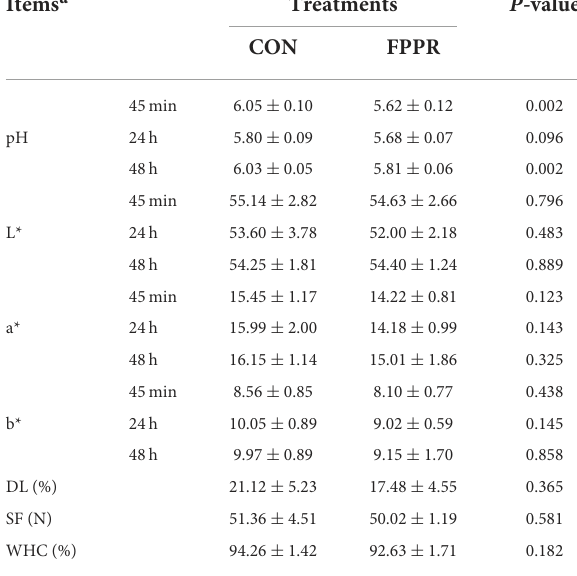
TABLE 2 Effect of the partial substitution of fermented pineapple peel residue (FPPR) for WSC on the meat quality of longissimus dorsi in Chuangzhong black goats.